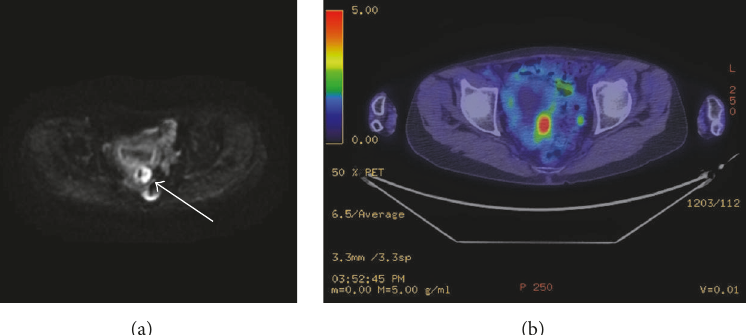
Figure 1: (a) Diffusion weighted magnetic resonance imaging. The abnormal signal with a diameter of approximately 2 cm on the left sidewall of the uterine corpus (at indicated by arrow). (b) FDG-PET. Abnormal uptake in the tumor had a maximal standardized uptake value (SUV (max)) of 7.79.